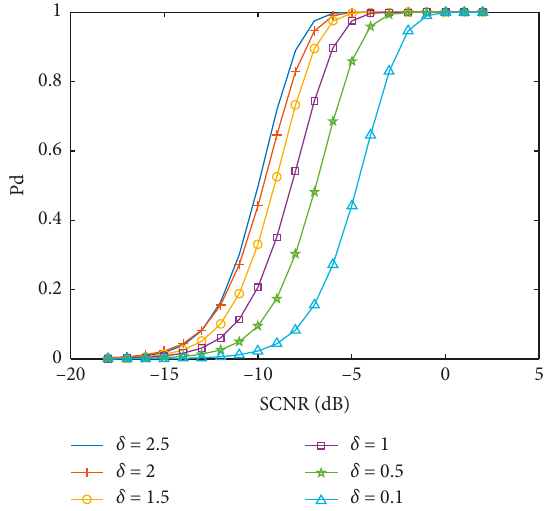
Figure 8: Detection probability versus SCNR. Algorithm 4: phase- quantized sequence.